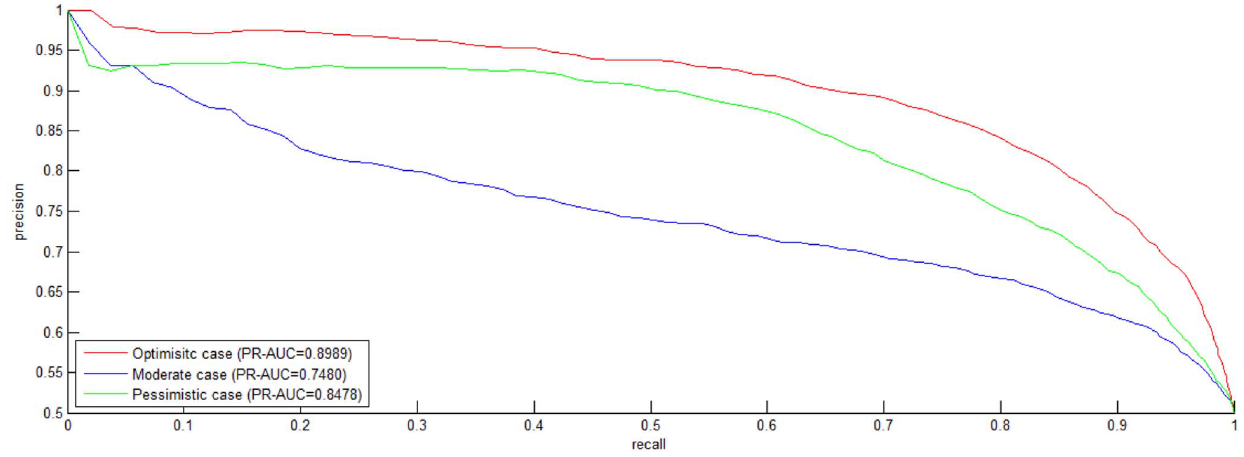
Figure 5. Precision-Recall(PR)curve on S2 dataset. The negative data is constructed by by the negative data sampling method of random sampling . The PR curves in red, blue and green indicate the performance for the Optimistic case, the Moderate case and the Pessimistic case, respectively.